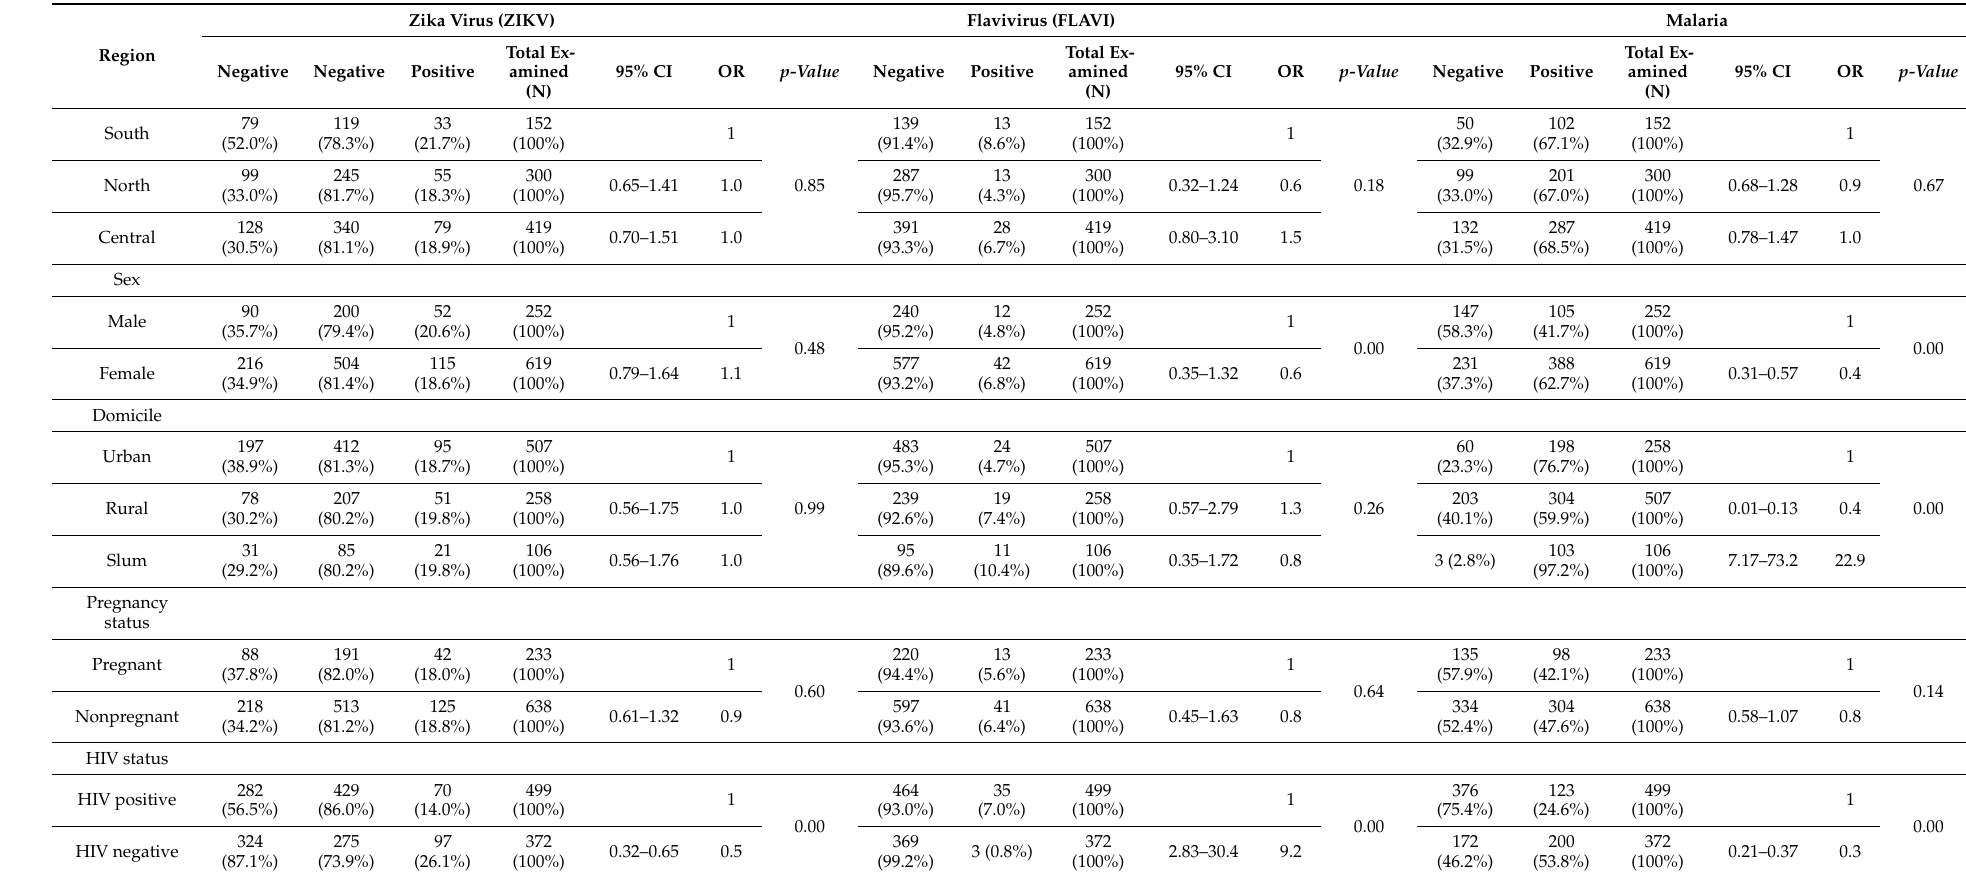
Table 2. Demographic characteristics of participants and ZIKV, FLAVI, and malaria antibody